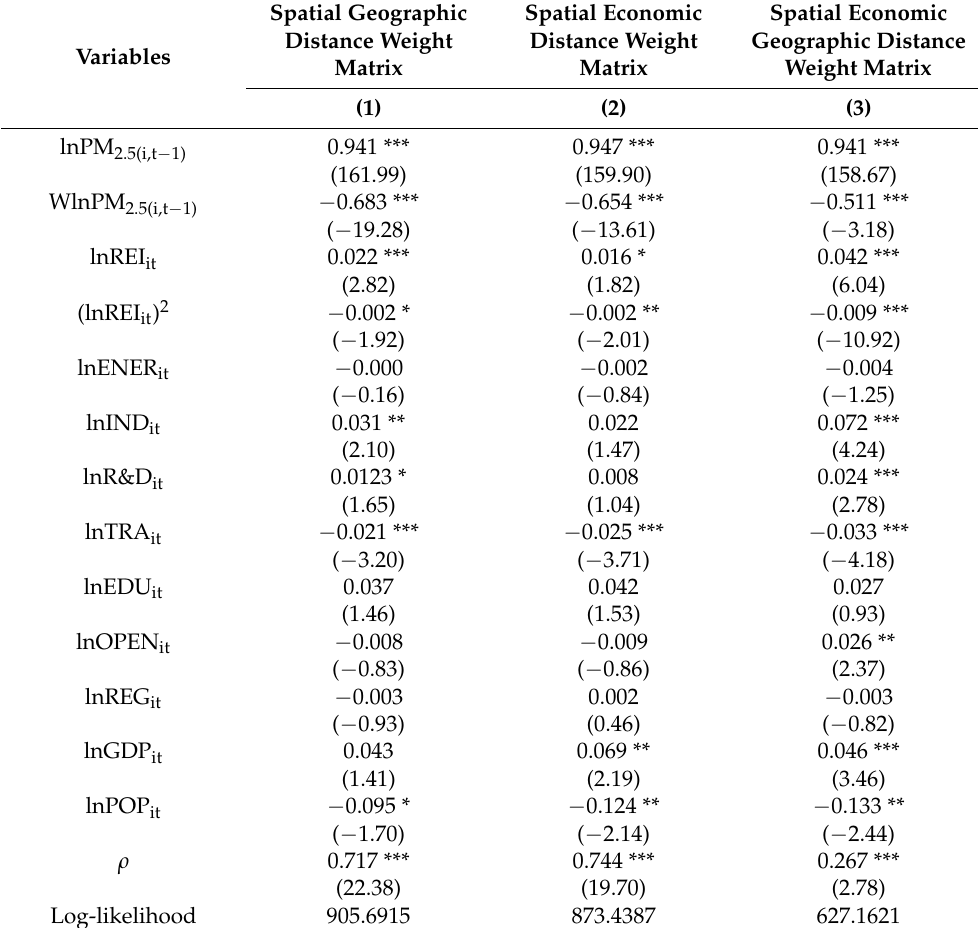
Table 6. Results of the robustness